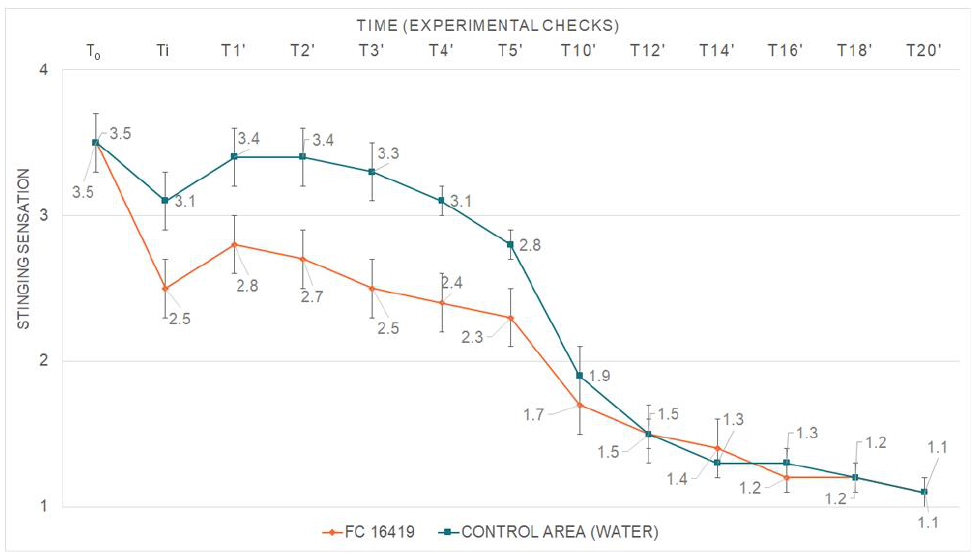
Figure 1. Clinical scoring of stinging sensation at different timepoints (Data are reported as mean ± SEM).